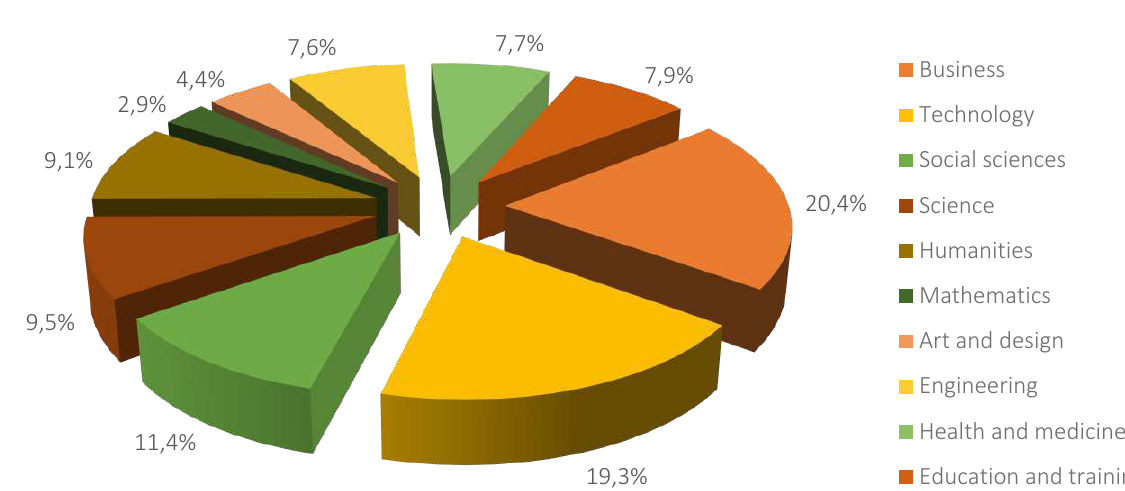
Figure 7. MOOC Distribution by the course,